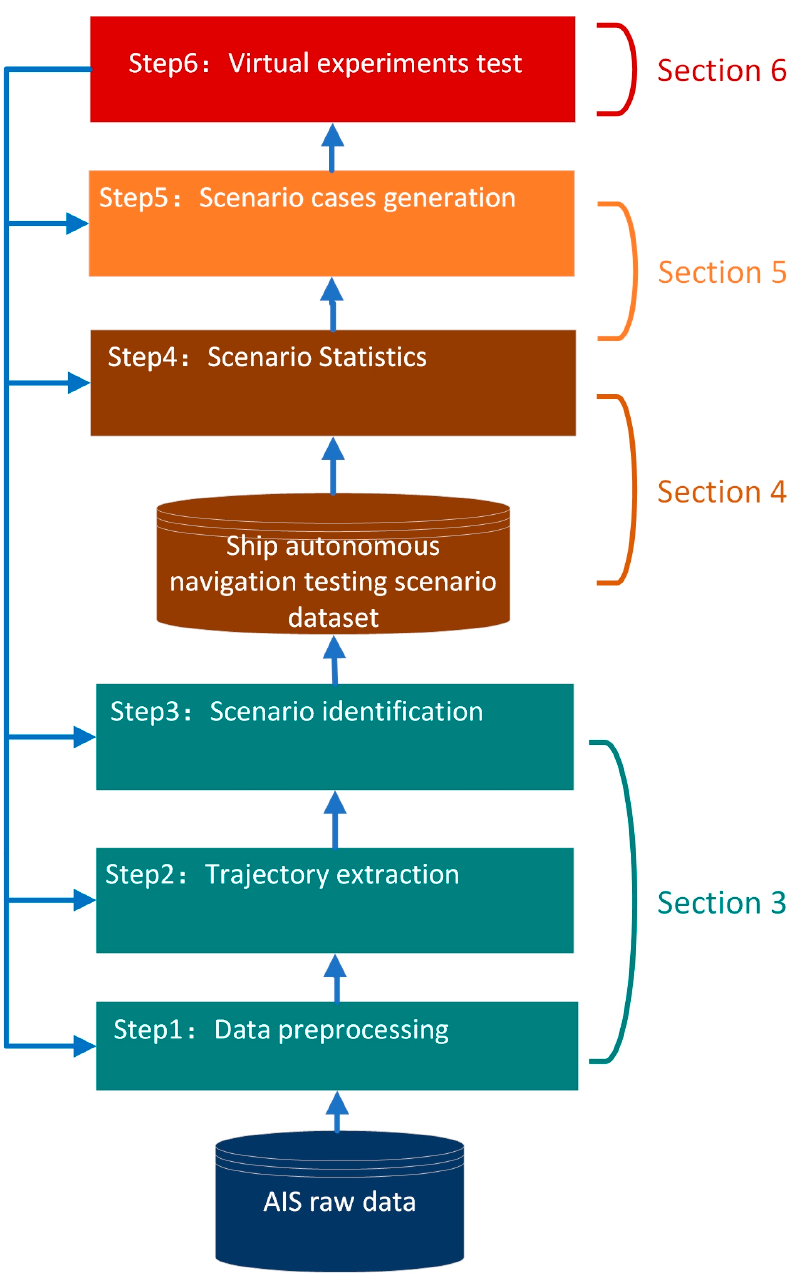
Figure 1. The overall framework of mining the encounter scenarios from AIS data for testing autonomous collision avoidance algorithms.